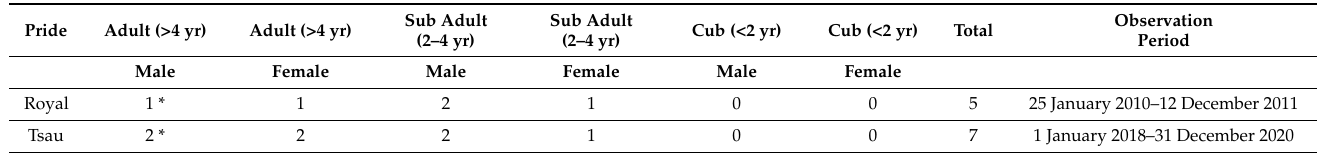
Table 1. Pride composition of the Royal pride and the Tsau pride, at the Tula-Tsau Conservation Area (7 km 2 ) (24 ◦ 23 (cid:48) S/31 ◦ 98 (cid:48)